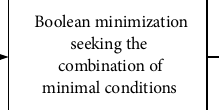
Figure 1. csQCA method flow